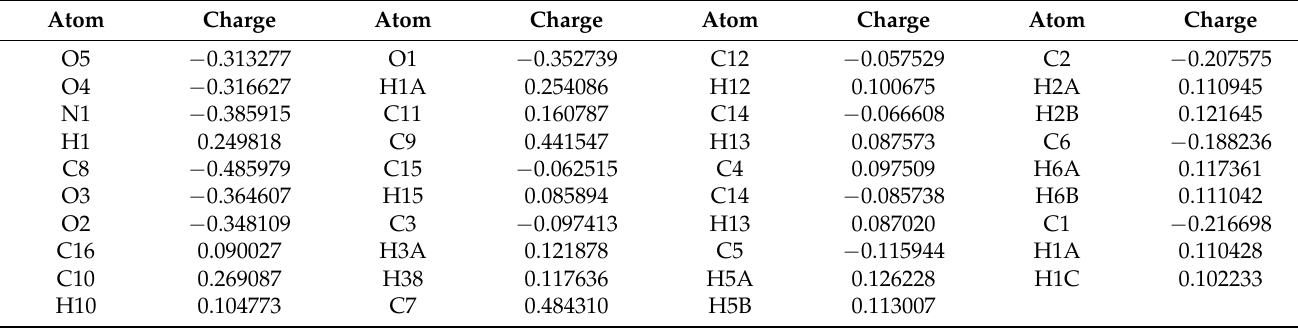
Table 6. The B3LYP-computed Mulliken atomic charges (in a.u.) for